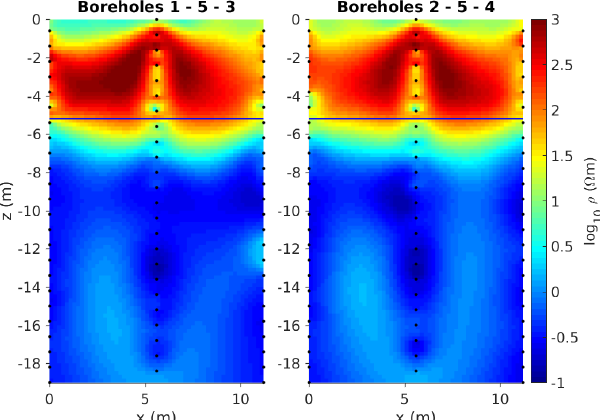
Figure 6. Inverted background ( T 0) images for both planes, in- cluding the unsaturated zone. Black diamonds denote the position of the electrodes and the blue line shows the groundwater table at